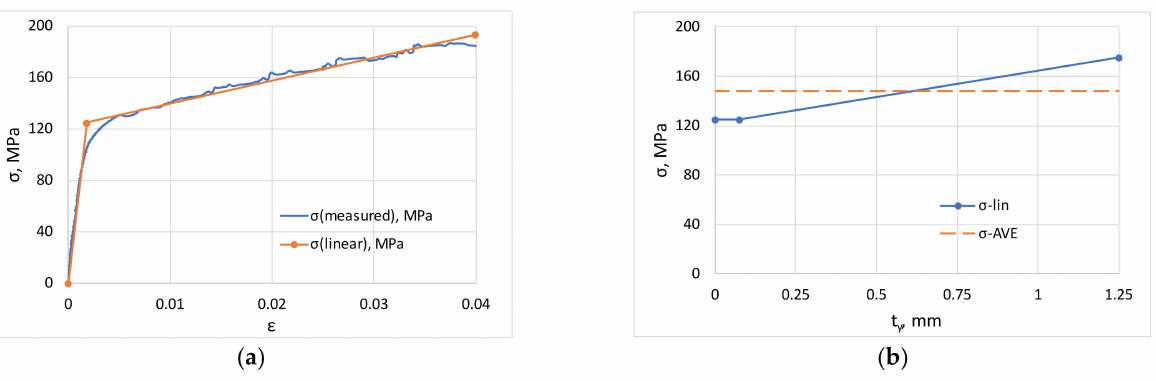
Figure 4. Material model and stress distribution ( a ) linear elastic-linear hardening model; ( b ) stress distribution along